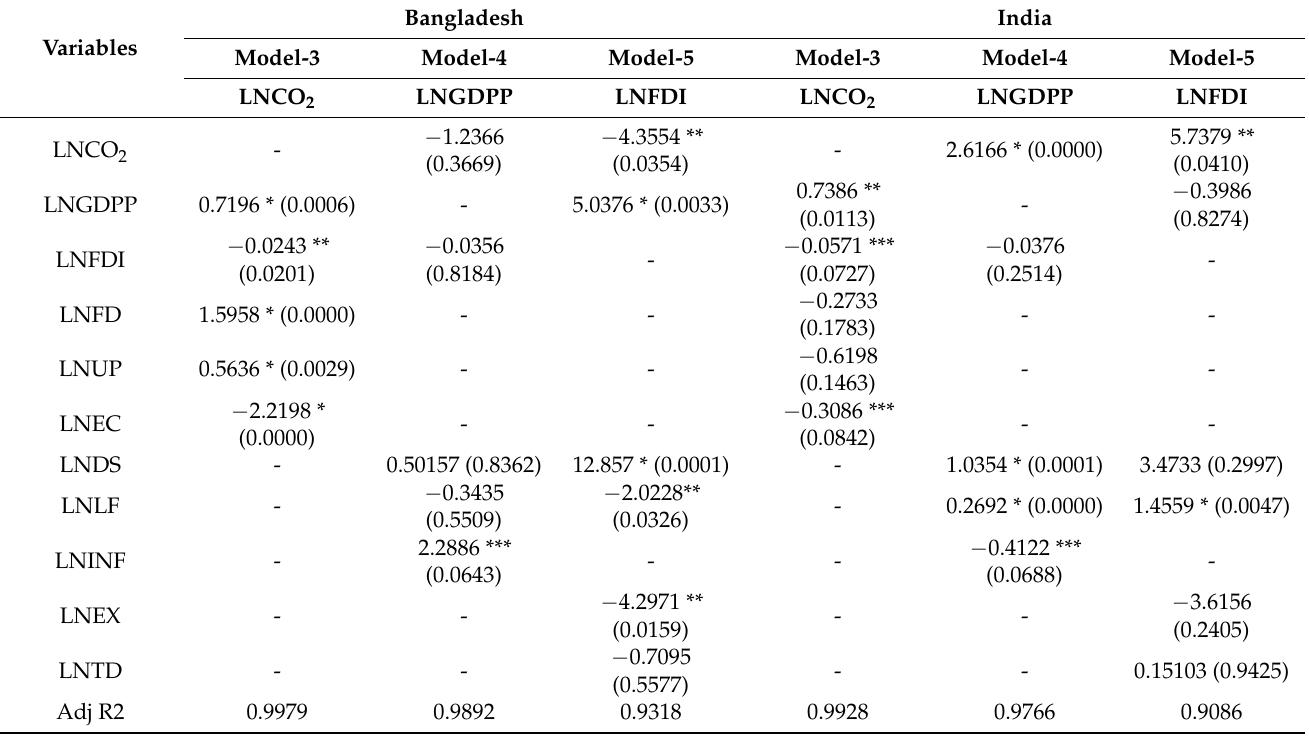
Table 5. Results for Individual Countries. Bangladesh and